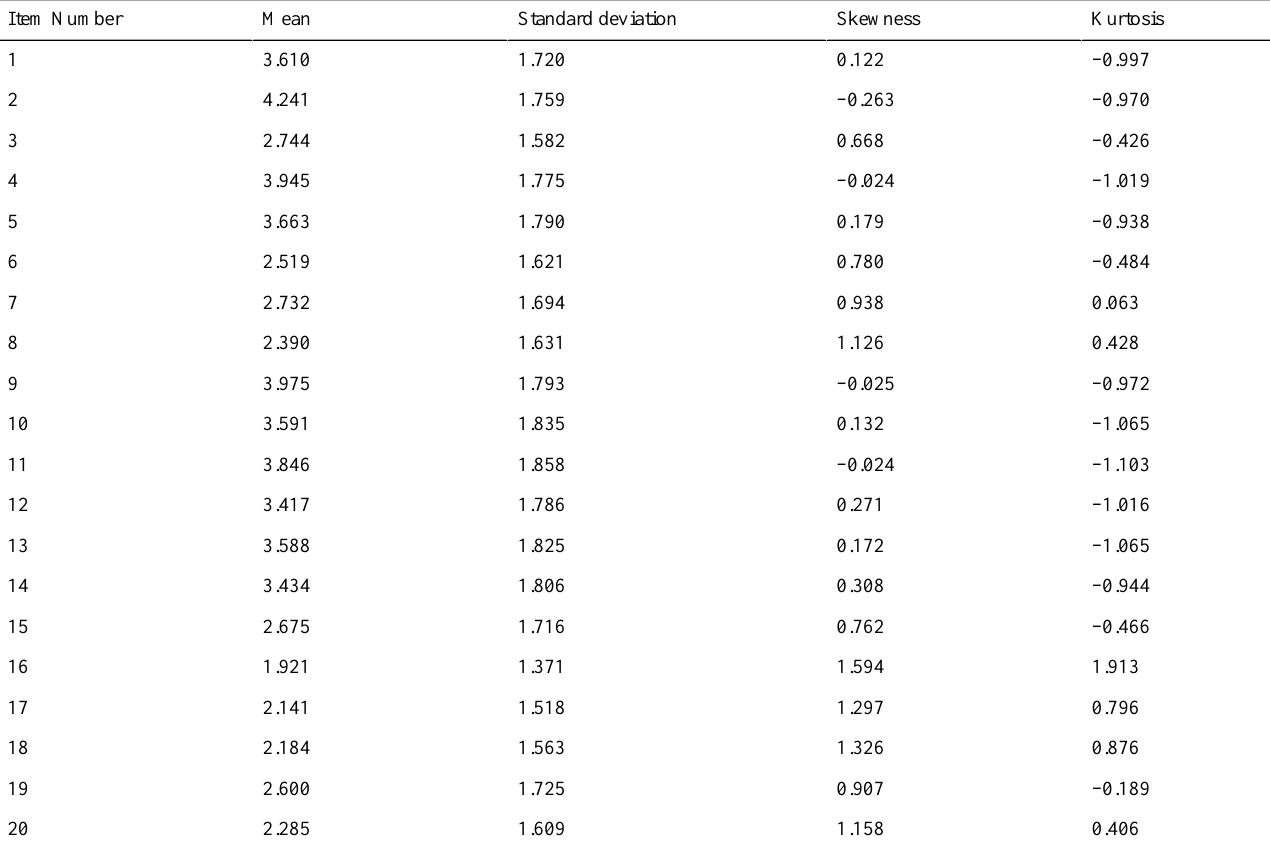
Table 1. Mean scores with standard deviation, skewness, and